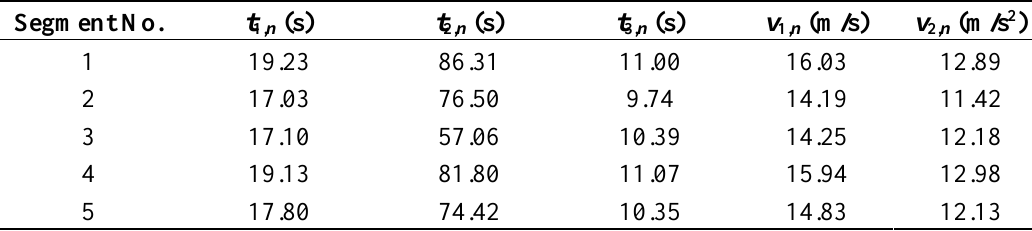
Table 3. The specified driving strategy of the pilot system.